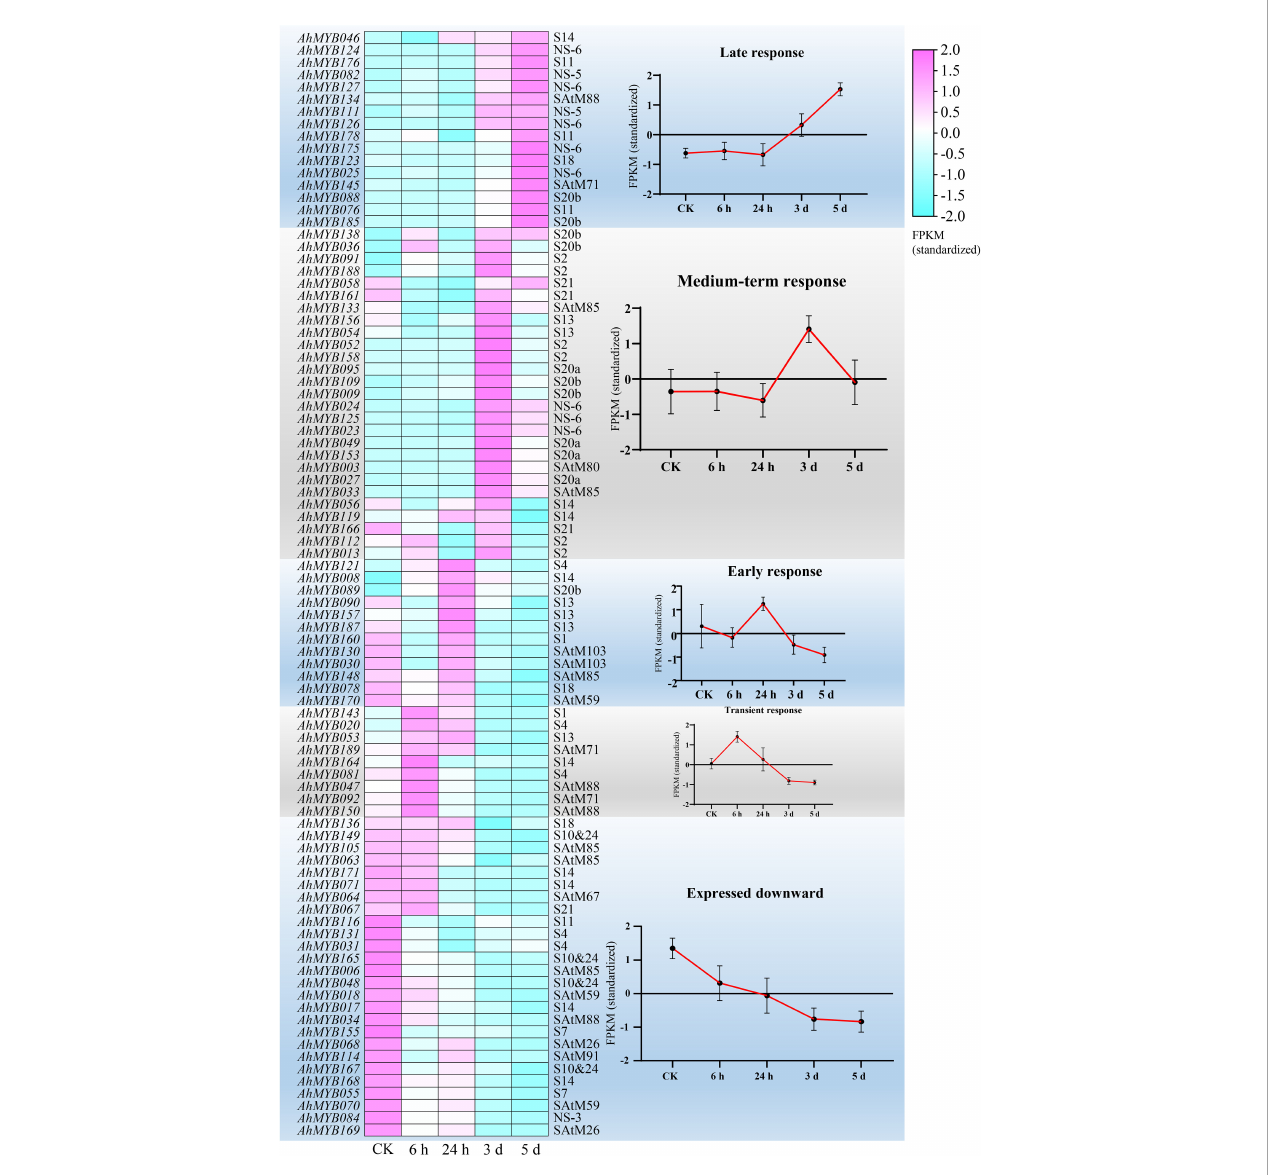
FIGURE 6 RNAseq transcript abundance patterns of 90 R2R3-MYB genes in root and stem tissues in fi ve expression groups during water logging stress are shown as a heat map. The left and right sides of the heatmap, respectively, showed the names of each gene and the subgroup to which it belonged. Heatmap hierarchical clustering was used to construct the expression pattern based on the fragments per kilobase of exon per million fragments (FPKM). The color scale, which ranged from -2.0 to 2.0, was displayed. The labels at the bottom of the heat map indicate, from left to right, the control group, 6 h, 24 h, 3 days, and 5 days after water logging